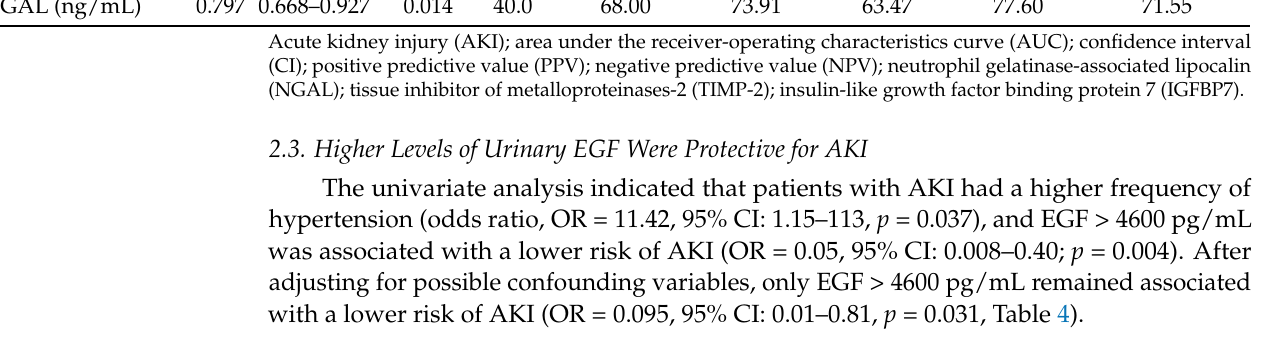
Table 4. Risk factors for acute kidney injury in critically ill COVID-19